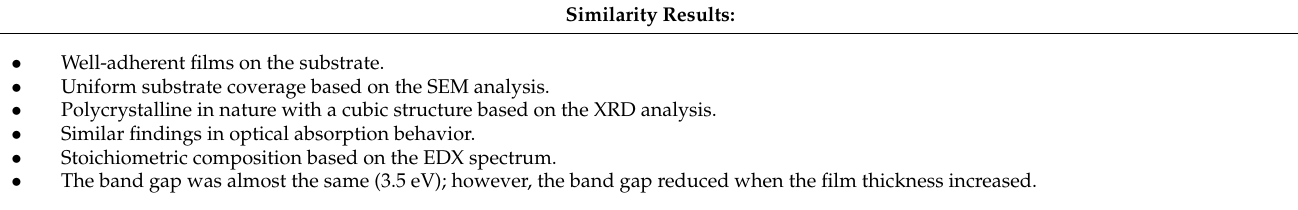
Table 2. Similarity and differences in zinc sulfide thin films prepared by using the SILAR method and thermal evaporation